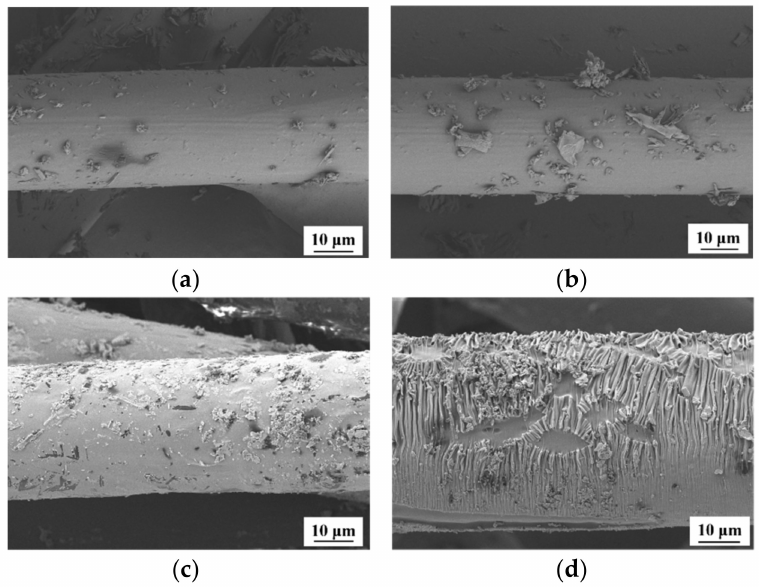
Figure 9. SEM of treated PP treatment fiber immersed in Na 2 SO 4 solution: ( a ) 7 h; ( b ) 12 h; ( c ) 3 d; ( d ) 7 d.